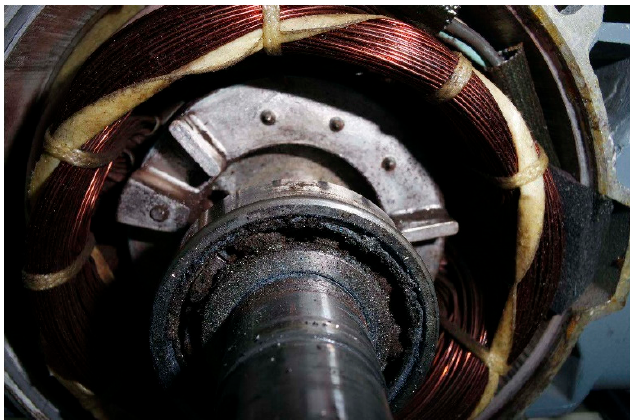
Figure 5. Bearing wear after the test run.